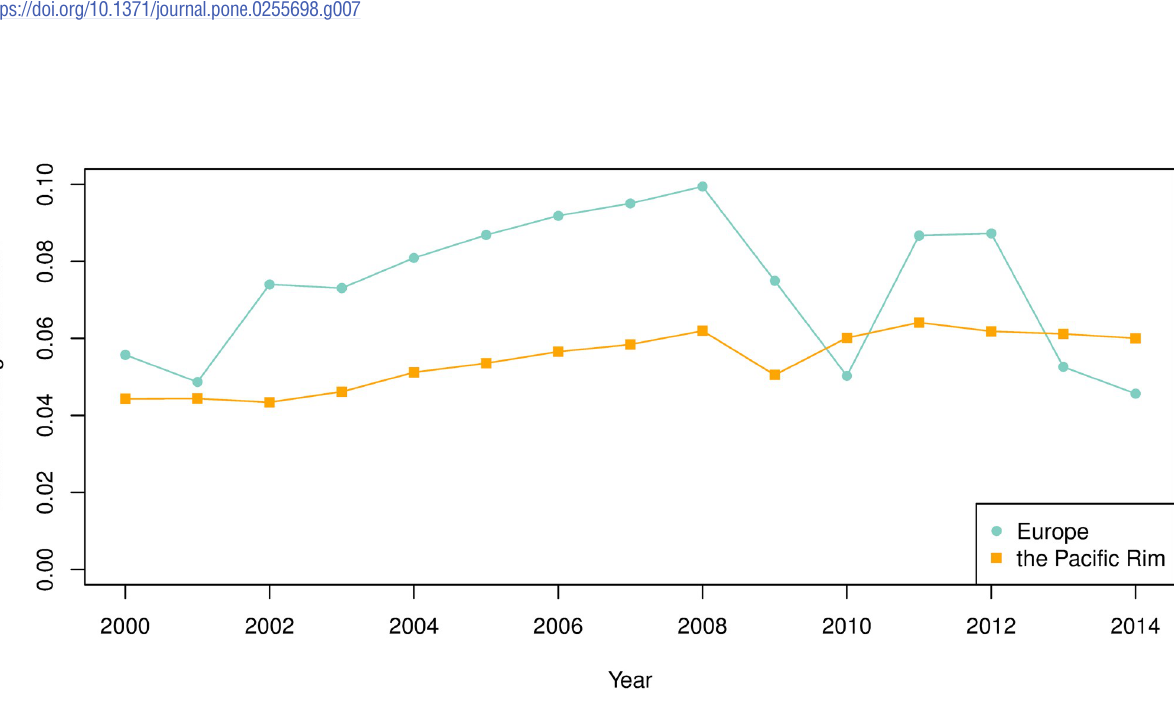
PLOS ONE | https://doi.org/10.1371/journal.pone.0255698 August 20,